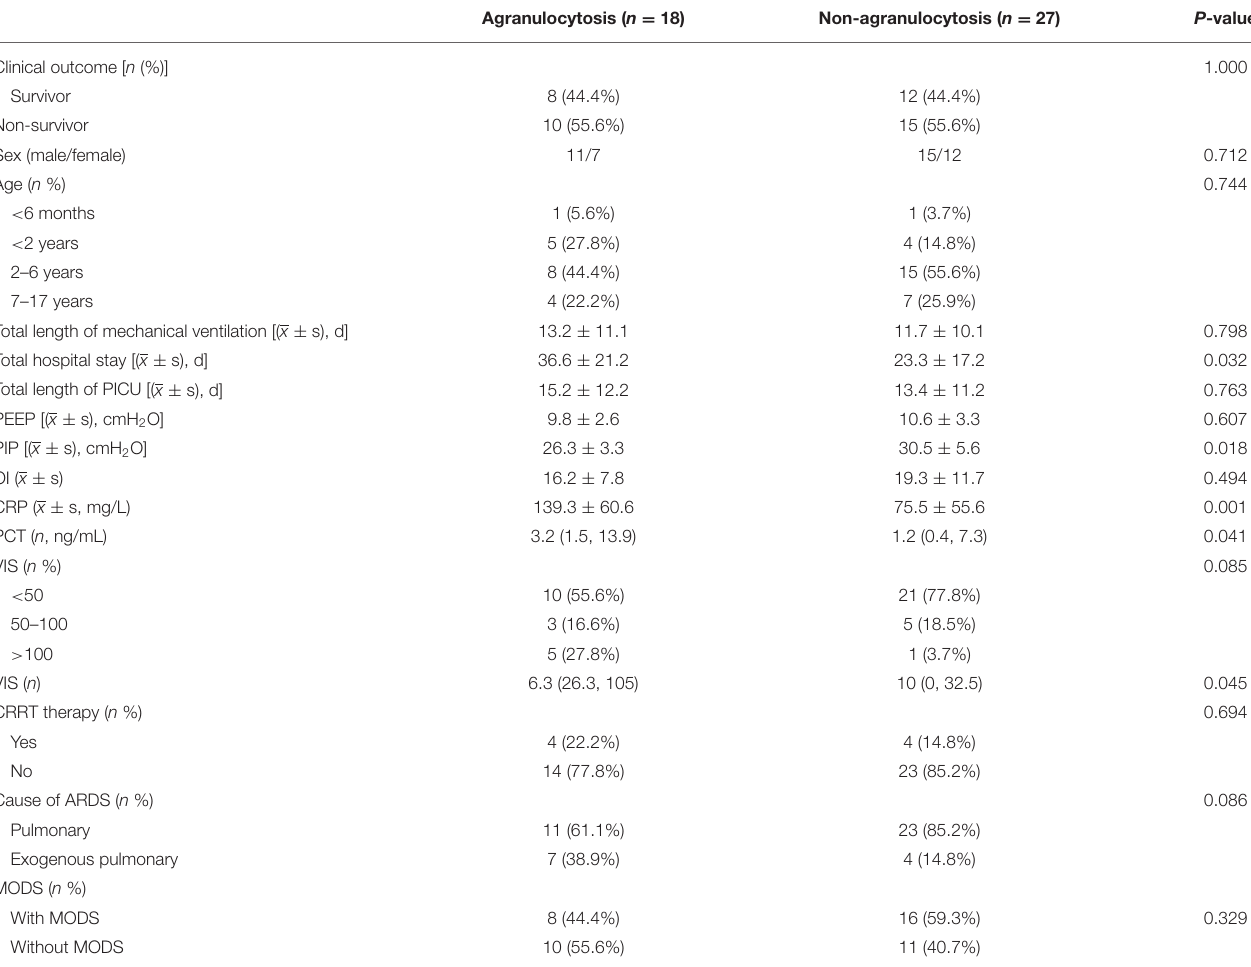
TABLE 4 | The characteristics of ARDS in children with hematologic neoplasms: agranulocytosis and non-agranulocytosis group. Agranulocytosis ( n = 18) Non-agranulocytosis ( n = 27) P -value Clinical outcome [ n